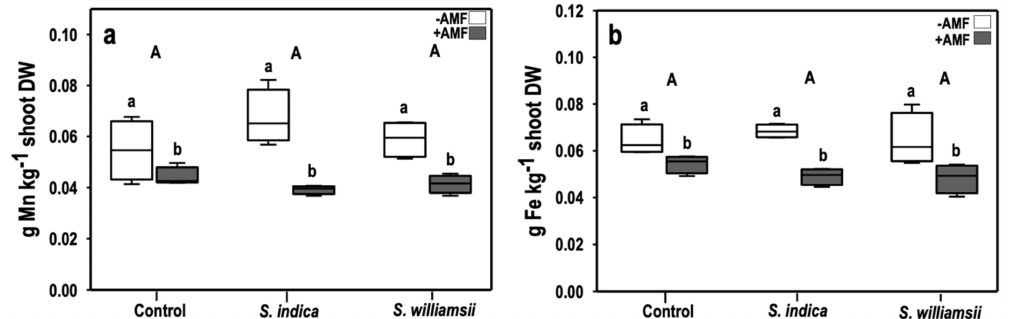
Figure 6. Manganese ( a ) and iron ( b ) concentrations (in g · kg − 1 shoot dry weight) in tomato shoots nine weeks after transplanting. Upper-case letters indicate the di ff erences in the main factor ‘ Serendipita ’. Lower-case letters indicate the di ff erences in the main factor ‘AMF’. Columns followed by the same letters are not significantly di ff erent (ANOVA, p < 0.05, n =